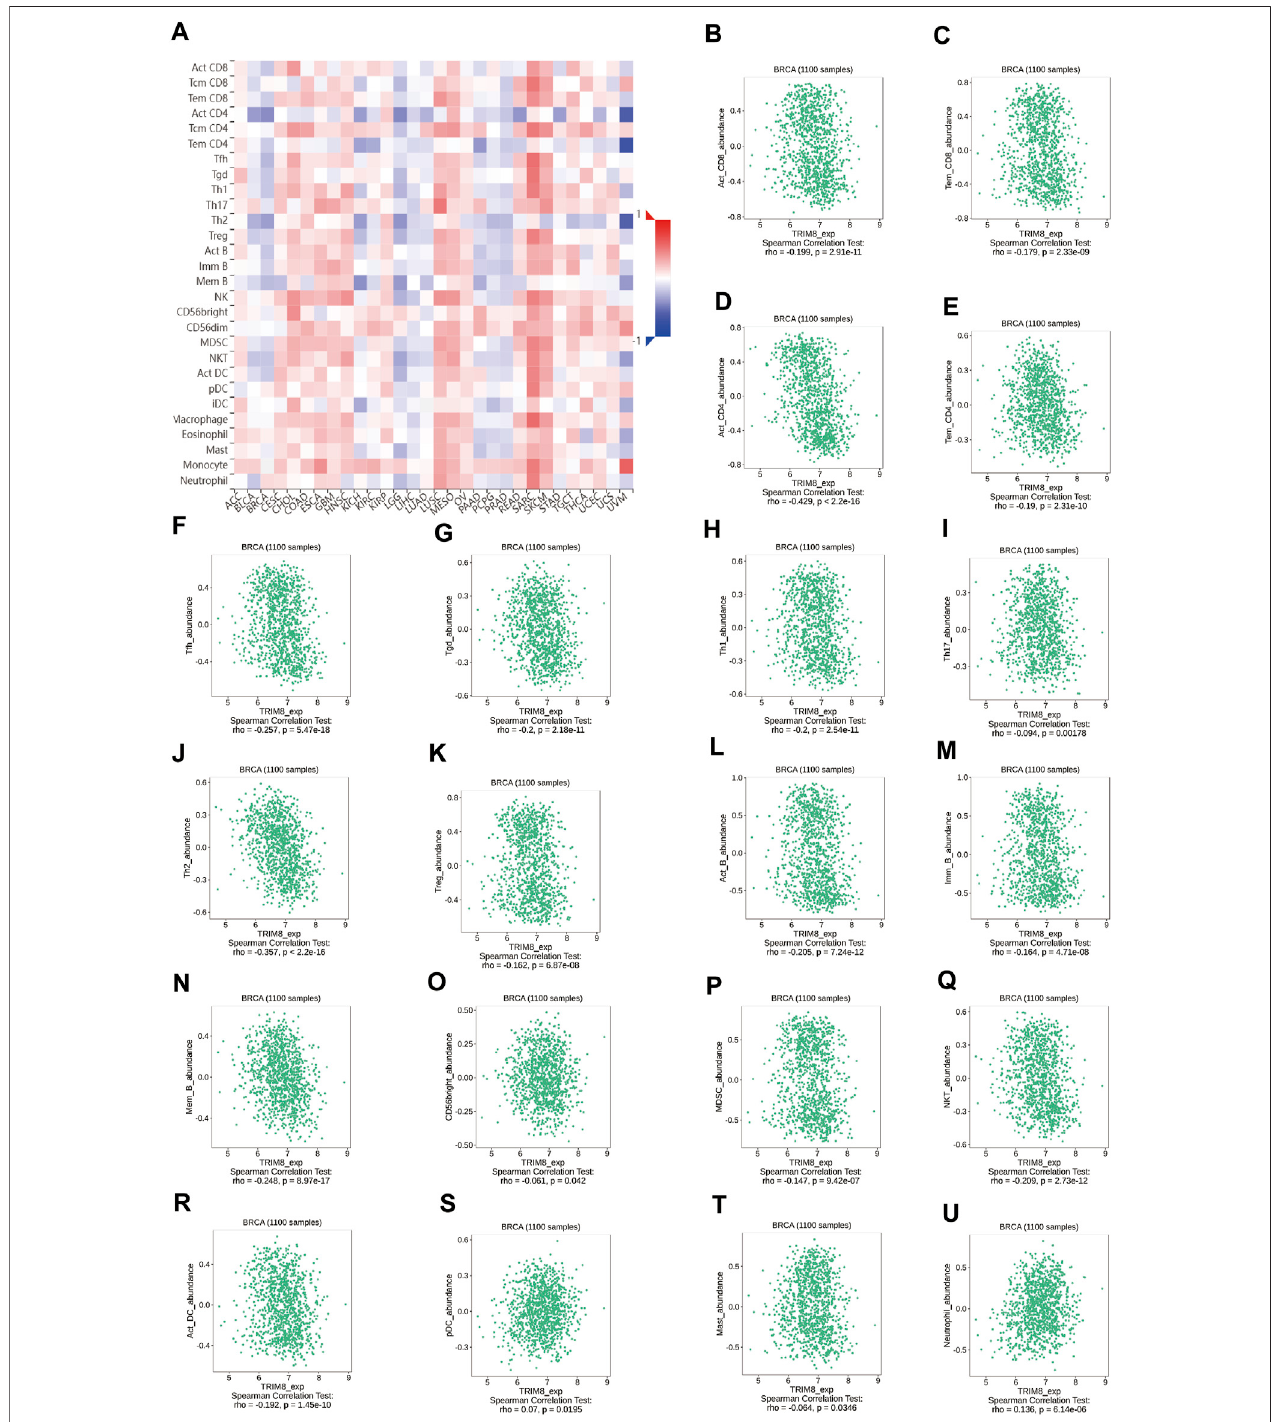
FIGURE 4 | Correlation between the expression of TRIM8 and immune cell subsets in patients with breast cancer based on the TISIDB database (A) Heatmap showed the relations between expression of TRIM8 and 28 types of TILs in breast cancer. The red color in the heatmap indicated a positive correlation, the blue color indicated a negative correlation, and the white color indicated a non-signi fi cant correlation. (B – U) The signi fi cantly correlation between the expression of TRIM8 and immune cell in fi ltrations.